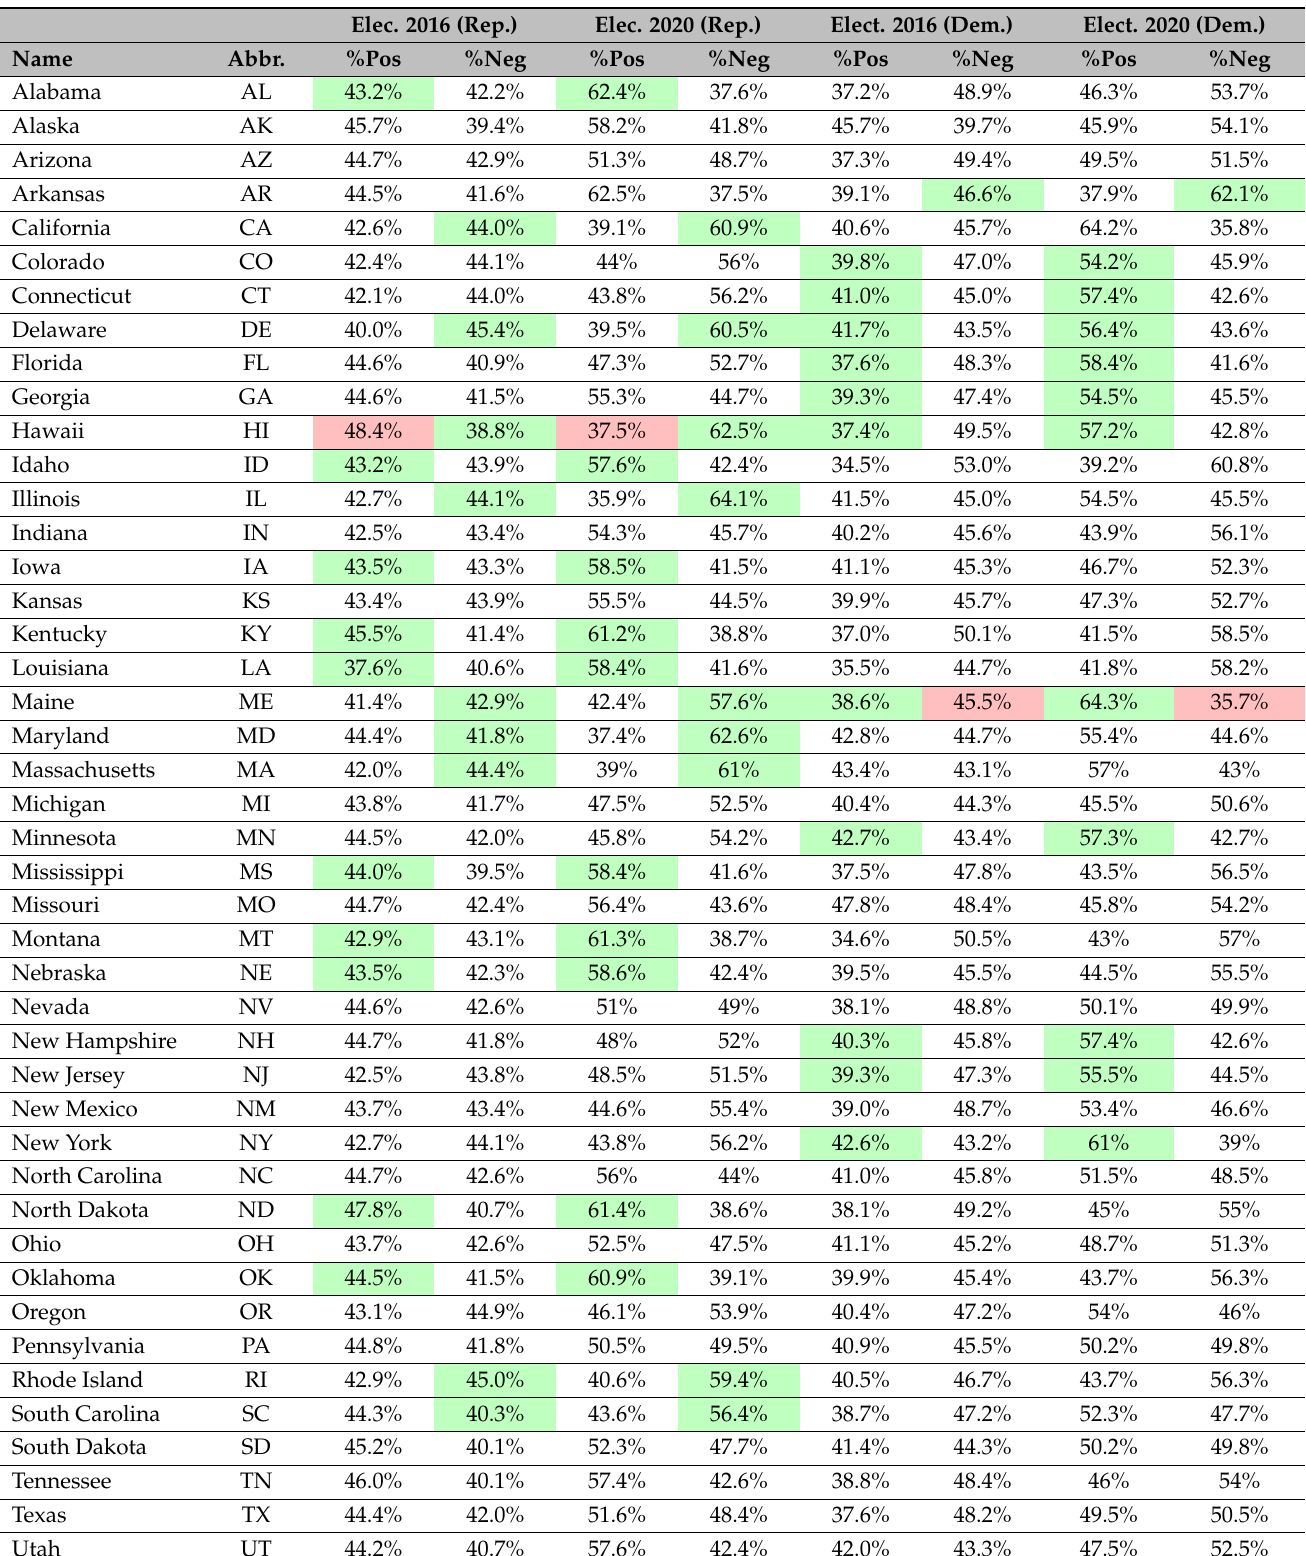
Table 3. Sentiment drift of users in elections of 2016 and